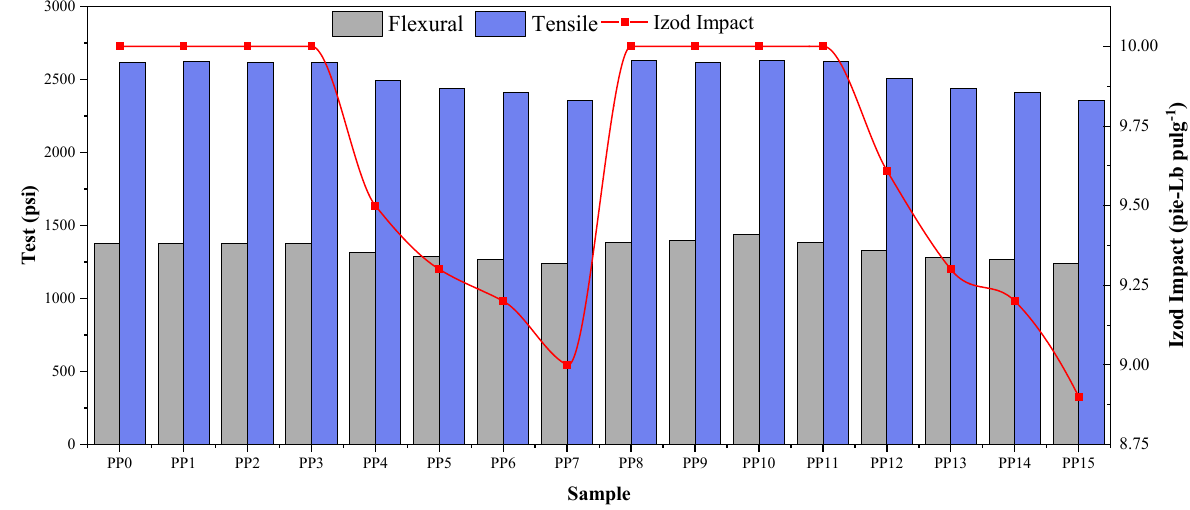
Figure 3. Flexural, tension, and impact tests of PP with acetylene and methyl acetylene.